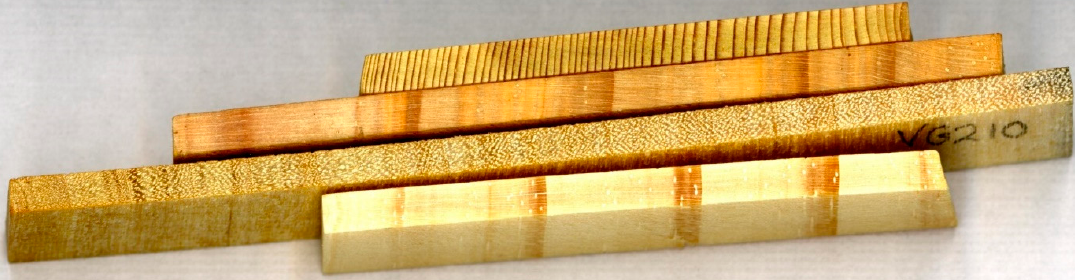
Figure 7. Samples prepared for SilviScan analysis.